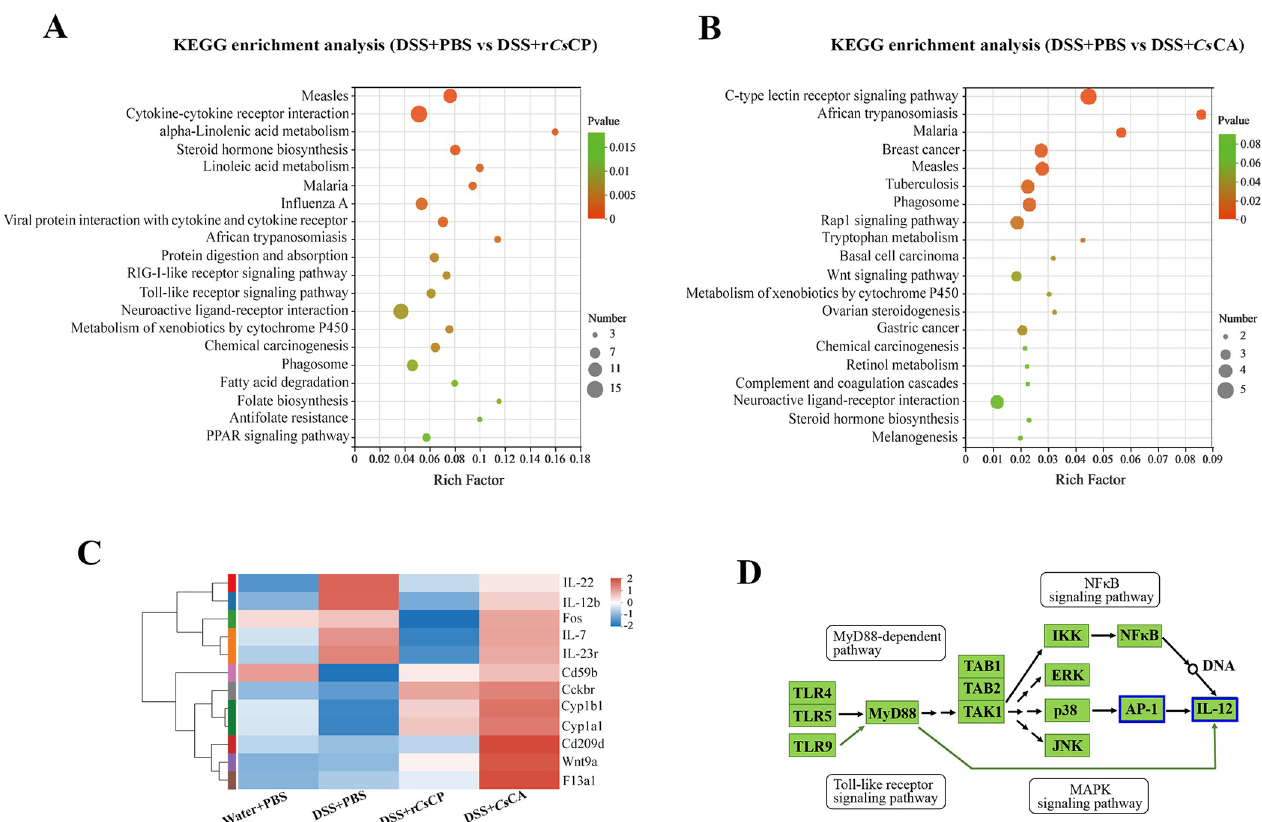
Fig 7. Critical signaling pathways and genes involved in r Cs CP- or Cs CA- treated DSS-induced colitis mice. (A) KEGG pathway enrichment analysis of the identified DEGs between DSS+PBS and DSS+r Cs CP groups. The top 20 most prominently enriched pathways were shown. (B) KEGG pathway enrichment analysis of the identified DEGs between DSS+PBS and DSS+ Cs CA groups. The top 20 most markedly enriched pathways are shown. (C) Heatmap for the top 12 DEGs involved in most enriched signal pathways after r Cs CP or Cs CA treatment. Red and blue indicate gene up- and down-regulation, respectively. (D) The mechanism of down-regulation of IL-12 gene in the colon of mice with acute colitis elicited by r Cs CP administration. The blue box indicates gene down